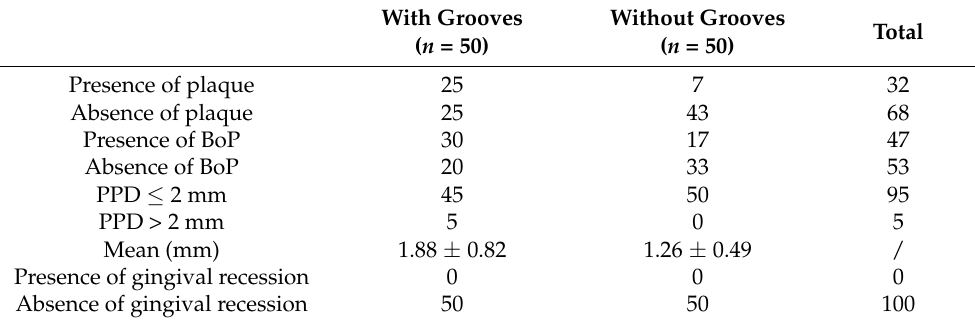
Table 2. Plaque Index, Bleeding on Probing (BoP) and Probing Pocket Depth (PPD) in teeth with and without radicular